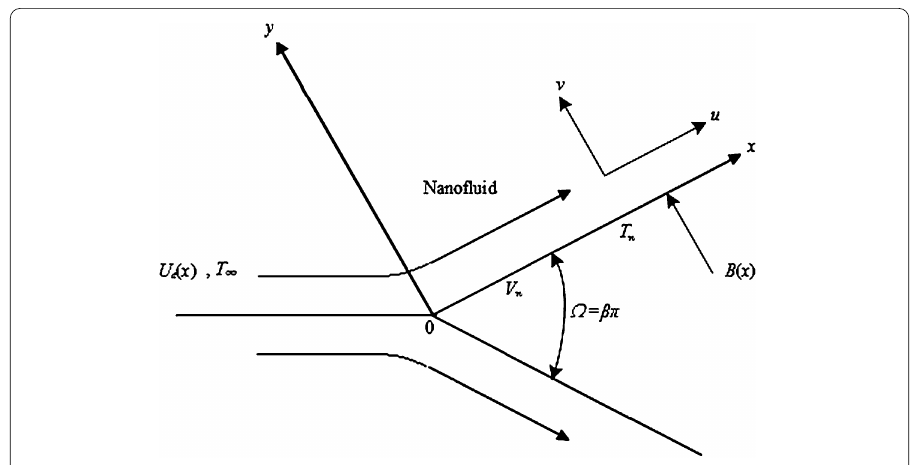
Figure 1 Physical model and coordinate